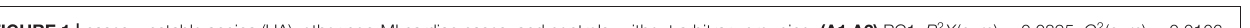
FIGURE 1 | cases, unstable angina (UA), other non-MI cardiac cases, and controls, without arbitrary grouping. (A1,A2) PC1: R 2 X (cum) = 0.0895, Q 2 (cum) = 0.0106; PC2: R 2 X (cum) = 0.167, Q 2 (cum) = 0.0356. (B1,B2) PC1: R 2 X (cum) = 0.205, Q 2 (cum) = 0.189; PC2: R 2 X (cum) = 0.310, Q 2 (cum) = 0.274; PC3: R 2 X (cum) = 0.386, Q 2 (cum) = 0.338. (3) Supervised PLS-DA modeling with the three groups: MI cases, non-MI chest pain cases, and controls. (A3) PC1: R 2 X (cum) = 0.073, R 2 Y (cum) = 0.339, Q 2 (cum) = 0.270; PC2: R 2 X (cum) = 0.128, R 2 Y (cum) = 0.544, Q 2 (cum) = 0.362; PC3: R 2 X (cum) = 0.174, R 2 Y (cum) = 0.635, Q 2 (cum) = 0.394. Permutation tests with the intercepts of R 2 < 0.23, Q 2 < − 0.20. (B3) PC1: R 2 X (cum) = 0.184, R 2 Y (cum) = 0.215, Q 2 (cum) = 0.207; PC2: R 2 X (cum) = 0.249, R 2 Y (cum) = 0.400, Q 2 (cum) = 0.377; PC3: R 2 X (cum) = 0.315, R 2 Y (cum) = 0.547, Q 2 (cum) = 0.512. Permutation tests with the intercepts of R 2 < 0.10, Q 2 < − 0.05. (4) Supervised PLS-DA modeling with the four groups: MI cases ( n = 85), UA ( n = 34), other non-MI cardiac cases ( n = 27), and controls ( n = 84). (A4) PC1: R 2 X (cum) = 0.073, R 2 Y (cum) = 0.259, Q 2 (cum) = 0.198; PC2: R 2 X (cum) = 0.132, R 2 Y (cum) = 0.397, Q 2 (cum) = 0.269; PC3: R 2 X (cum) = 0.173, R 2 Y (cum) = 0.492, Q 2 (cum) = 0.289. Permutation test with the intercepts of R 2 < 0.180, Q 2 < − 0.15. (B4) PC1: R 2 X (cum) = 0.183, R 2 Y (cum) = 0.169, Q 2 (cum) = 0.163; PC2: R 2 X (cum) = 0.254, R 2 Y (cum) = 0.300, Q 2 (cum) = 0.277; PC3: R 2 X (cum) = 0.317, R 2 Y (cum) = 0.422, Q 2 (cum) = 0.387. Permutation test with the intercept of R 2 < 0.11, Q 2 < − 0.05.